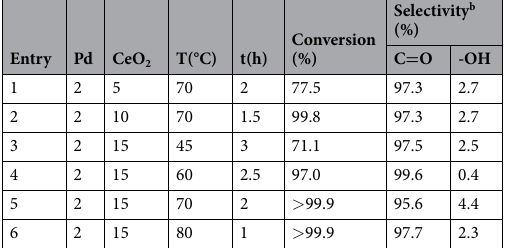
Table 2. Hydrogenation of phenol with Pd/ Ⓕ -CeO 2 /AC catalyst under various conditions a . a Reaction